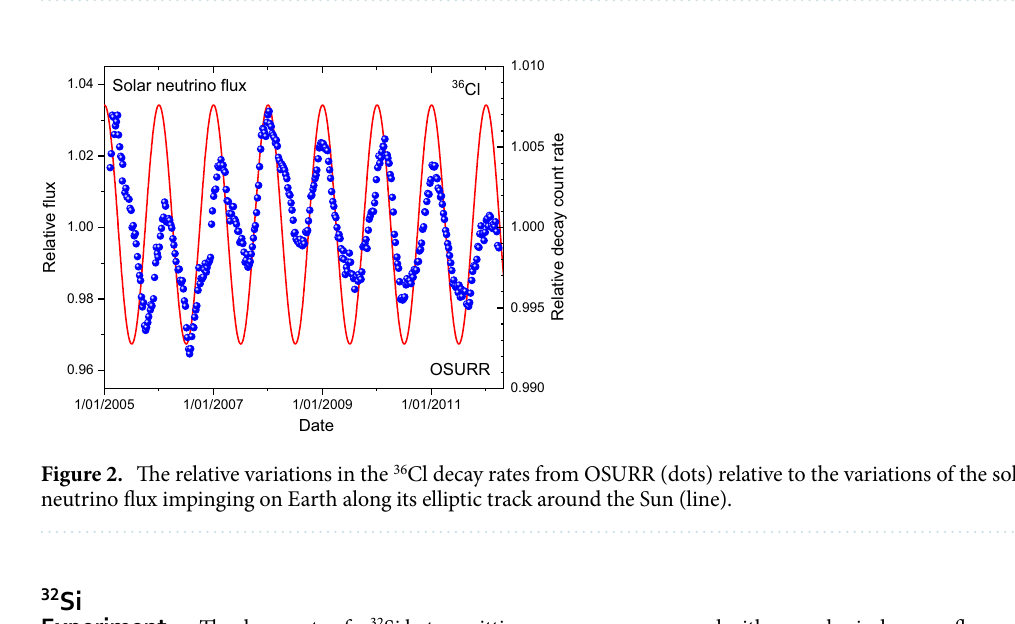
Figure 1. The relative variations in the 32 Si decay rates from BNL (dots) relative to the variations of the solar neutrino flux impinging on Earth along its elliptic track around the Sun (line).